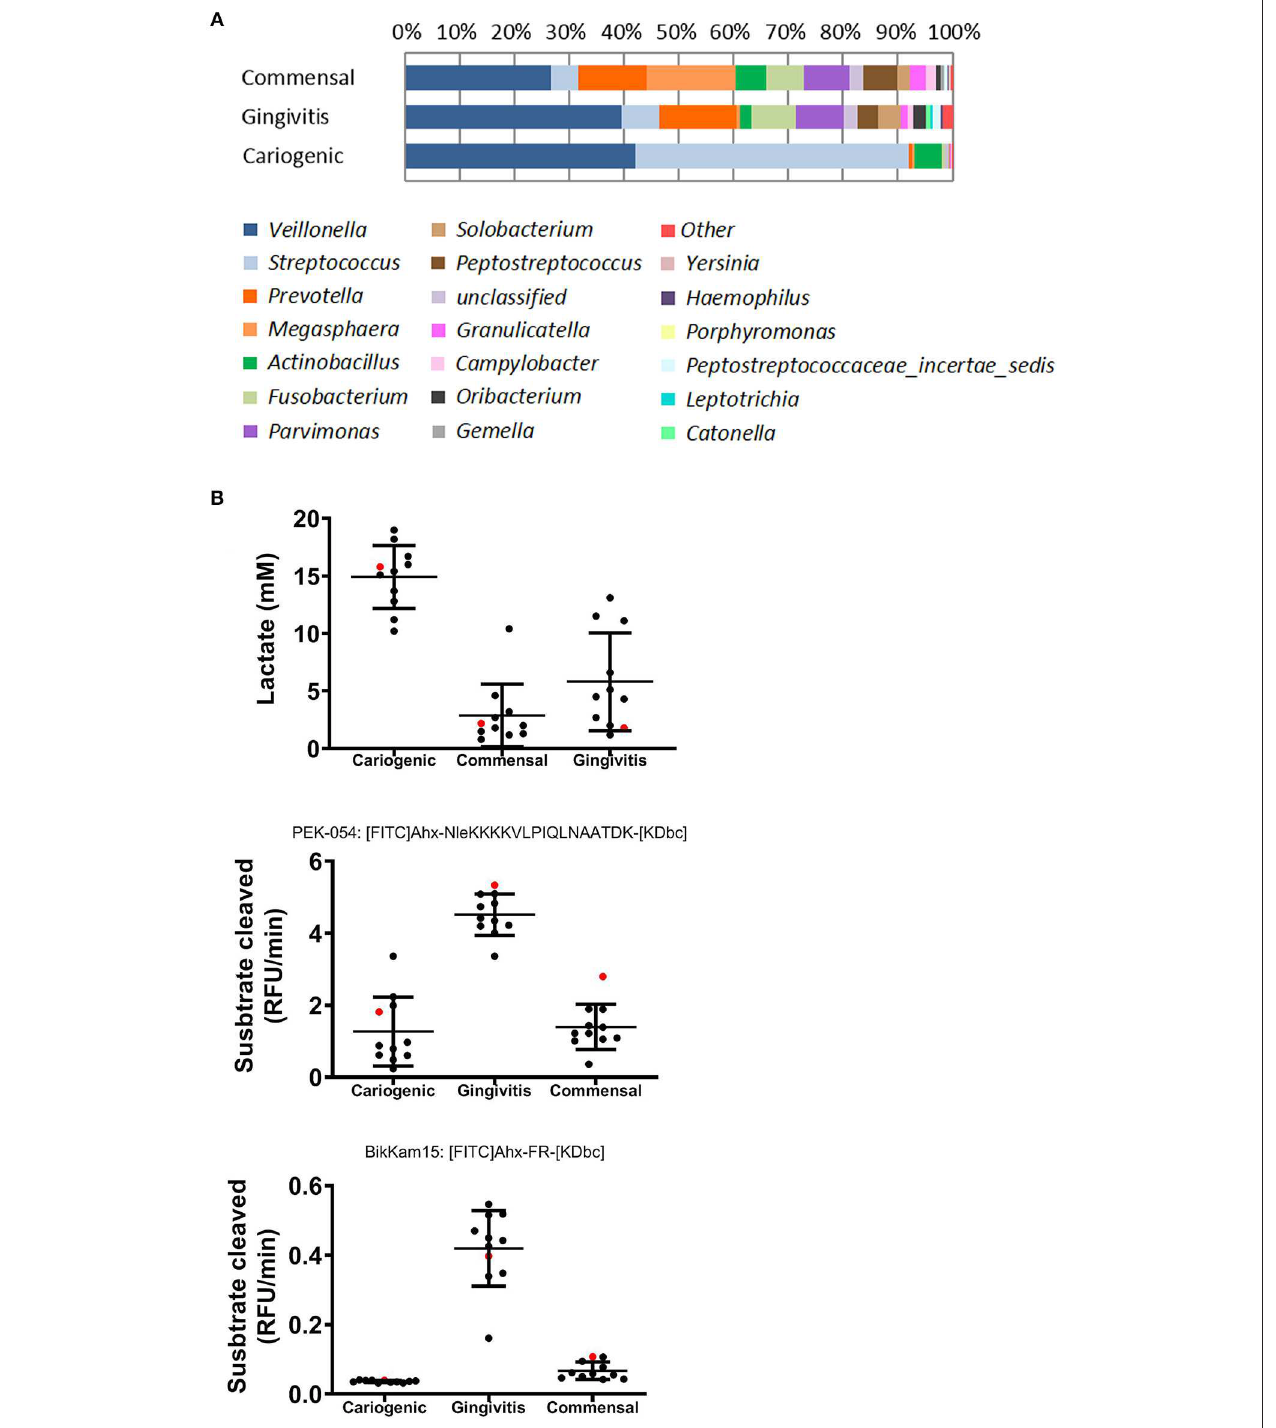
FIGURE 1 | Composition and metabolites of commensal, gingivitis, and cariogenic biofilms. (A) Relative abundance of major bacterial genera of the three biofilms is shown. Remaining genera are included in “other”. (B) Lactic acid production, total protease activity (FRET probe: PEK-054) and gingipain protease activity (FRET probe: BikKam15) of biofilms that were cultured from saliva of individual donor (in black) or pooled saliva (in red). The same biofilms were used in this study as previously used in Janus et al. (2015) and Buskermolen et al. (2017).